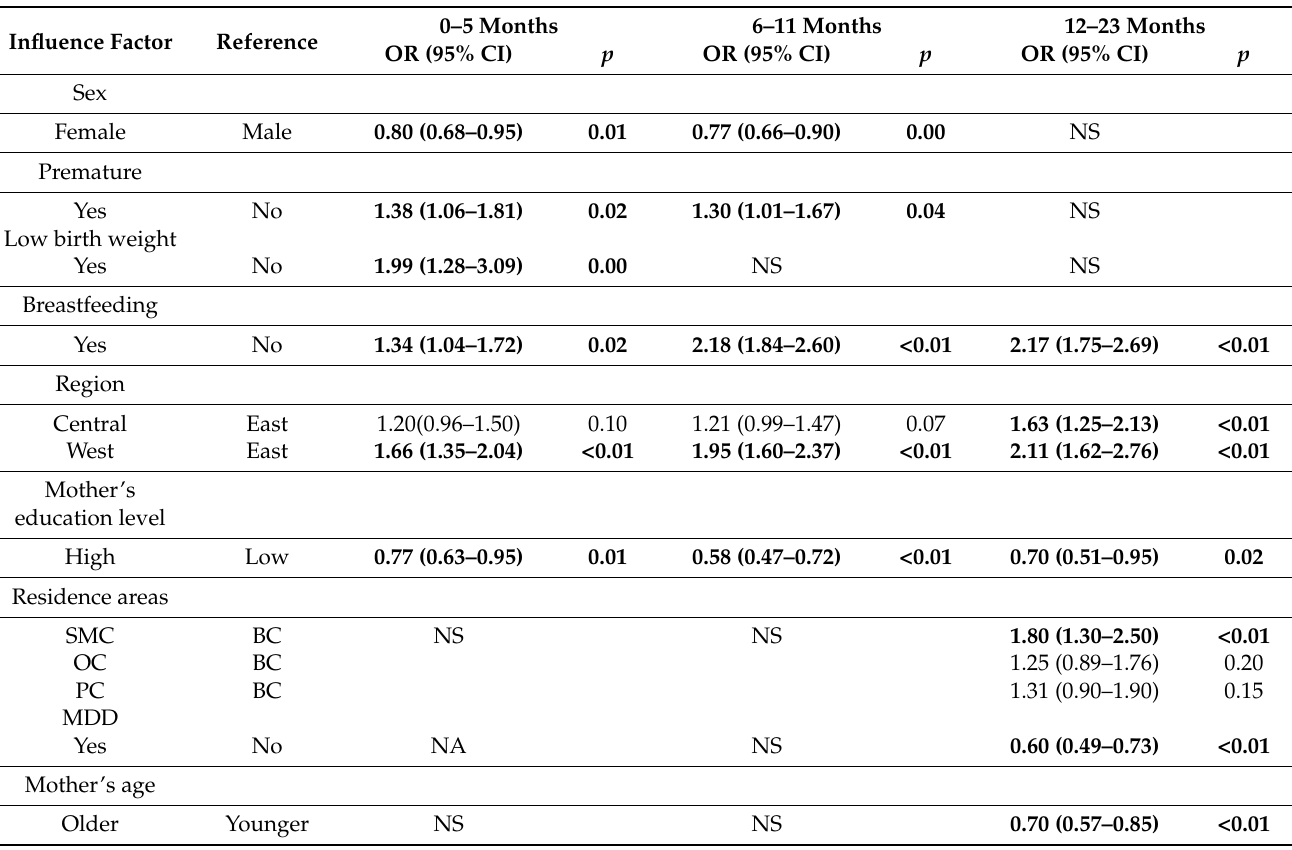
Table 4. Factors associated with anaemia among children aged 0–23 months, based on multivariate logistic regression